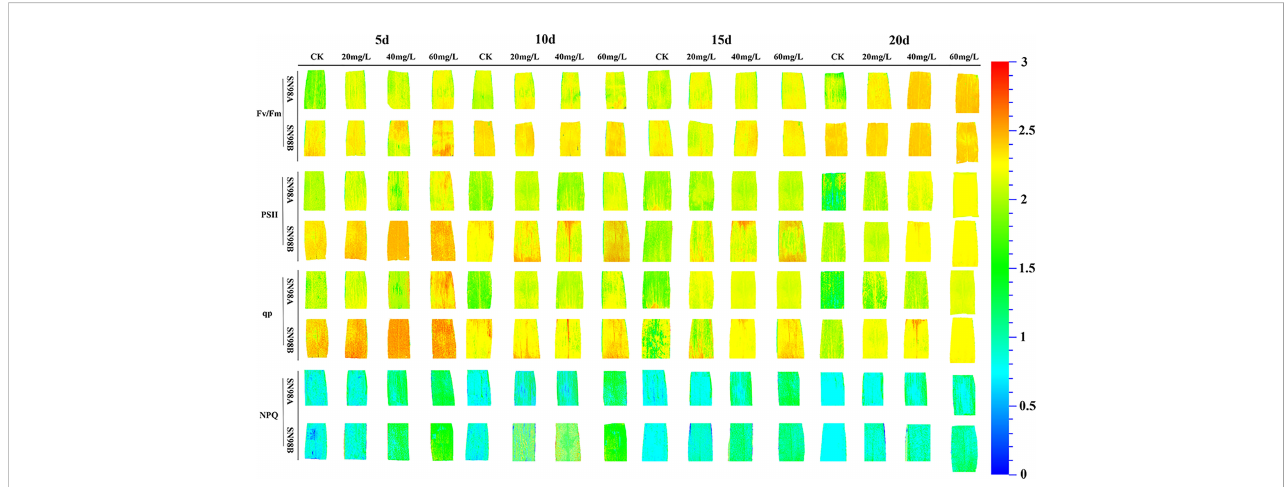
FIGURE 3 Effects of GA 3 application on chlorophyll fl uorescence according to in situ imaging of inbred maize lines with differences in light sensitivity under low light stress conditions. In the fi gure panels, 5d, 10d, 15d, and 20d denote the number of days under shading treatment; 20, 40, and 60mg L – 1 denote the GA 3 concentrations applied; and CK denotes the water control